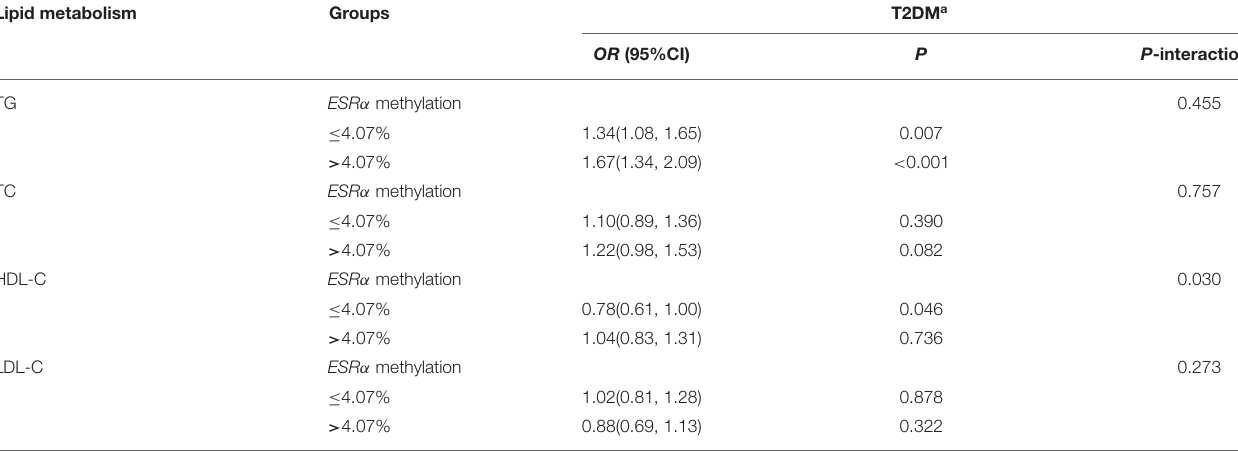
TABLE 5 | Interactive effects of ESR α methylation and lipid metabolism indexes on T2DM. Lipid